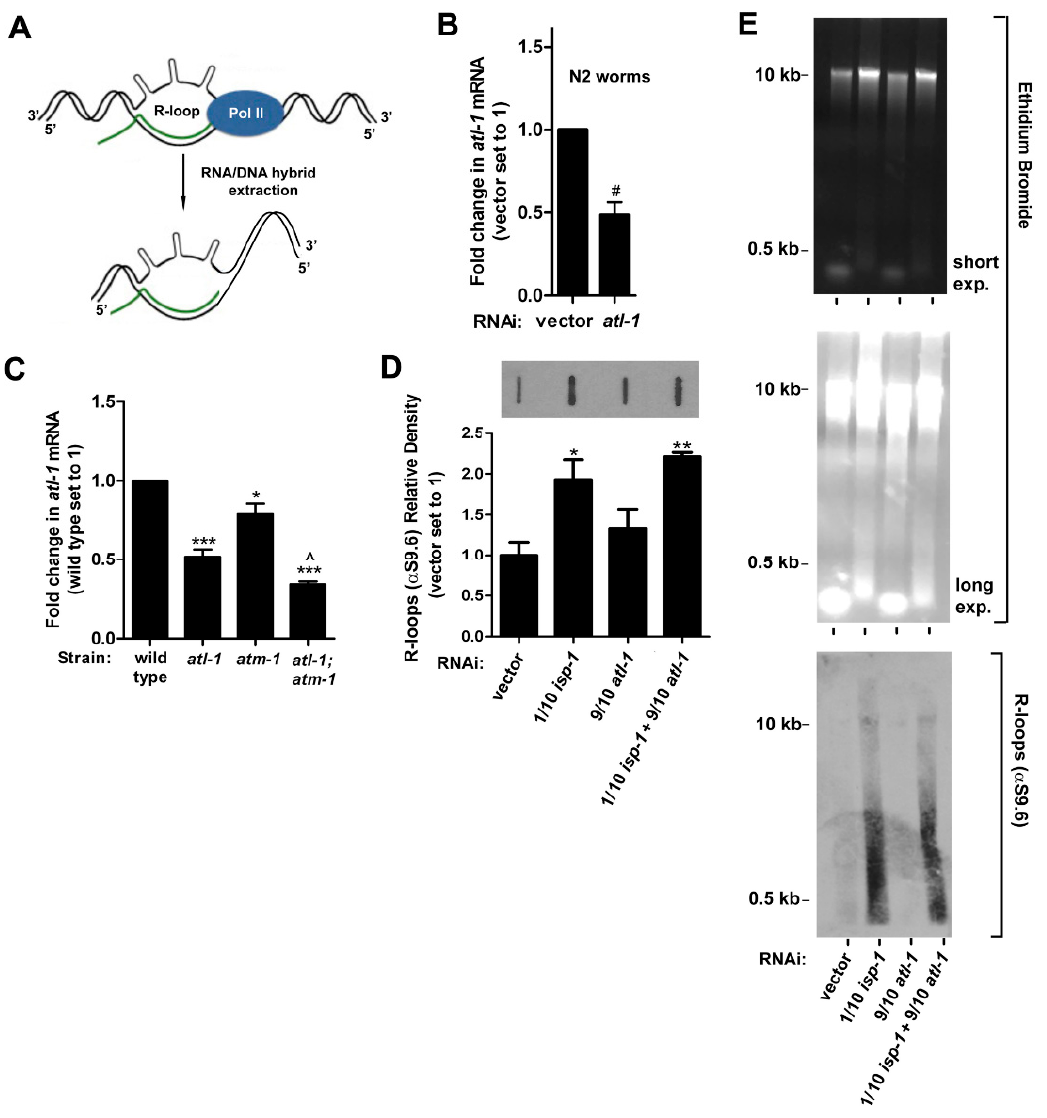
Figure 6. Evidence for RNA Pol II stalling following mitochondrial ETC stress. ( A ) Schematic showing genesis of R-loops following stalling of RNA Polymerase II. Modified from [57] . ( B , C ) RNAi knockdown of atl-1 in wild type (N2) worms reduces atl-1 transcript abundance to the same extent